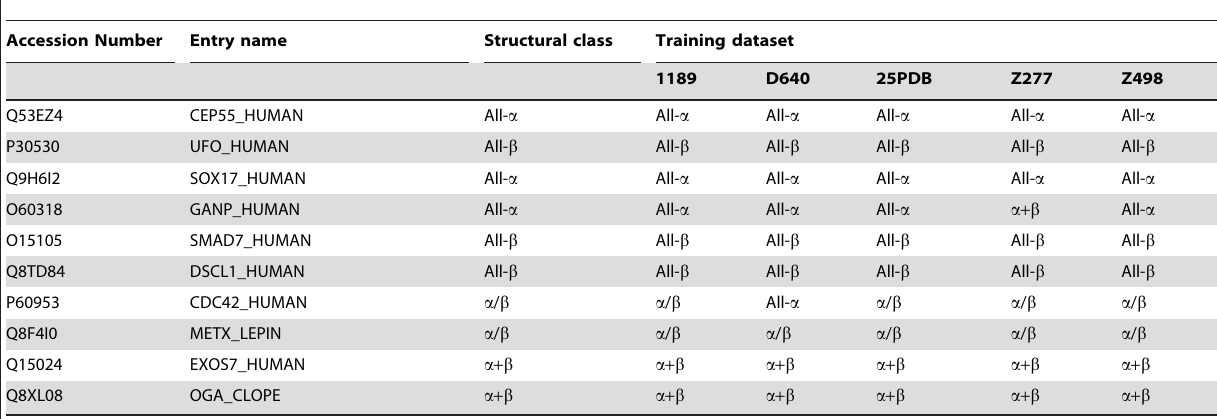
Table 10. Examples to show the predicted results by our predictor based on five datasets.